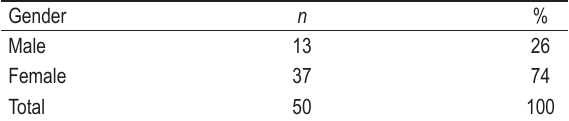
TABLE 1. Gender structure of the respondents